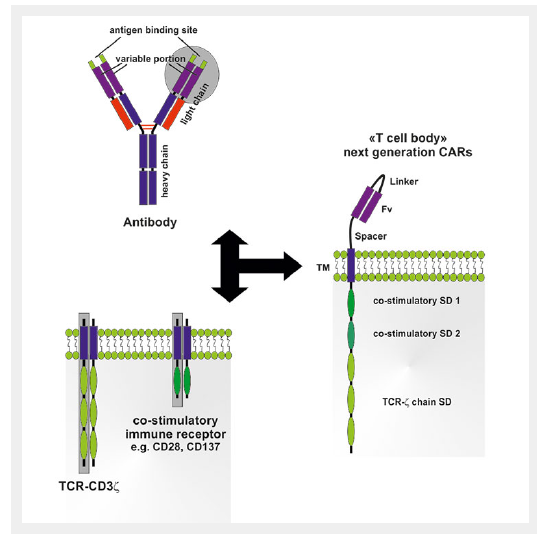
Structure and assembly of next-generation chimeric antigen receptors (CARs). CARs are comprised of the variable portion (Fv) from an antibody with a defined specificity for a tumour antigen linked via a transmembrane domain (TM) to intracellular signaling domains (SDs) from the T cell receptor (TCR)-complex (CD3ζ chain), as well as one or several SDs from co-stimulatory receptors (e.g. CD28, OX40, CD137). Consequently, T cells expressing genetically engineered CARs can be activated independent of antigen- presenting cells; recognition of tumour antigen by the Fv-portion results in full activation of T